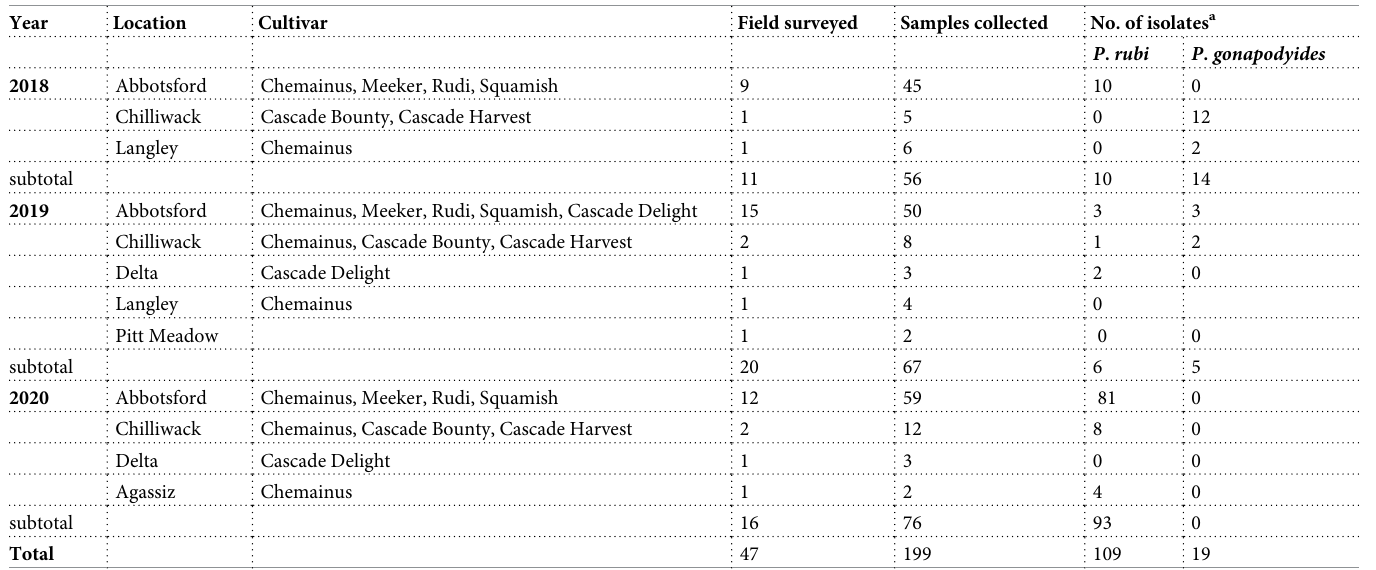
Table 1. Sampling details and Phytophthora rubi and Phytophthora gonapodyides isolates from diverse fields, locations and